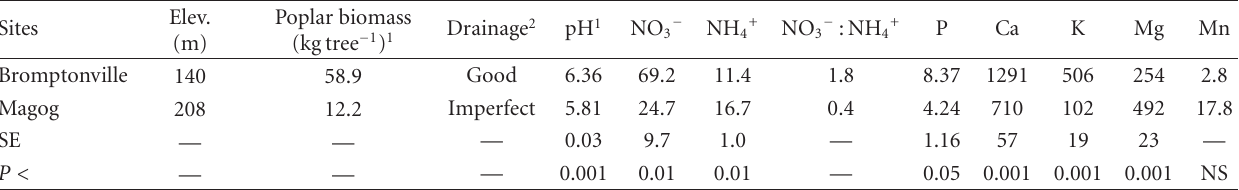
Table 1: Site and soil characteristics at the two riparian sites: elevation, mean aboveground poplar dry biomass (including leaves), soil drainage class, pH, and nutrient supply rate ( µ g10cm − 2 15d − 1 ). The NO 3 − :NH 4+ nutrient supply rate molar ratio is also indicated. For nutrient supply rate, PRS-Probes were buried during a 15 day period in late August 2007.